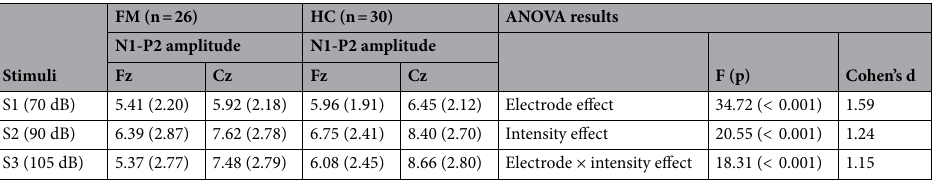
Table 4. Left: Mean N1-P2 amplitude (in µV) in Fz and Cz electrodes for each tone intensity (standard deviation in parentheses), for the patients (FM) and healthy controls (HC). Right. Repeated measures ANOVA analysis significant results and effect sizes (Cohen’s d).